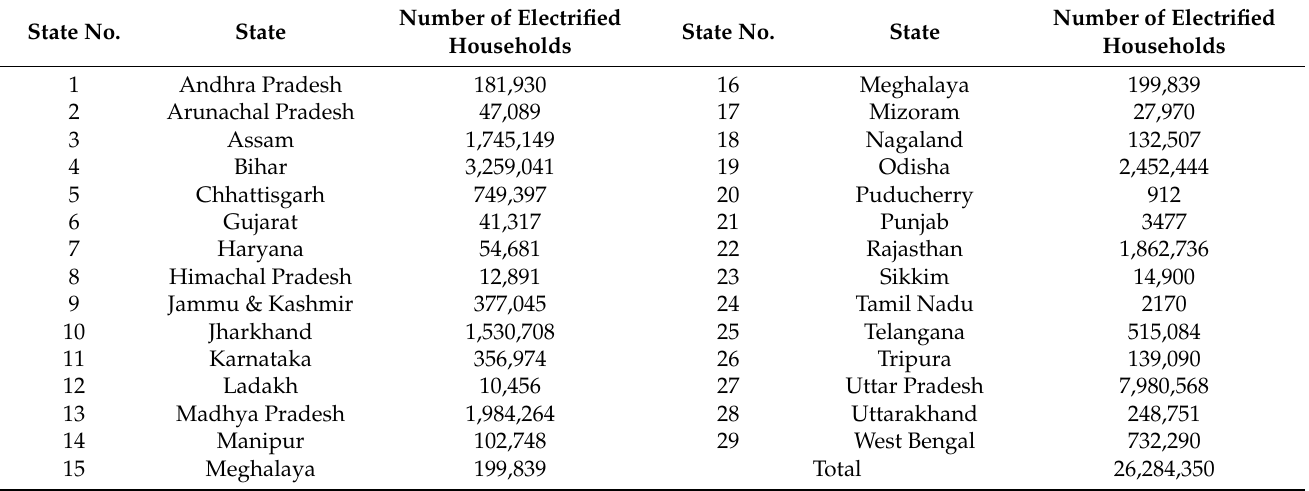
Table 7. Households, by state, electrified under Saubhagya since launch of the scheme, i.e., 11 October 2017 to 31 March 2019. Source: Ministry of Power, Central Electricity Authority, Govern- ment of India